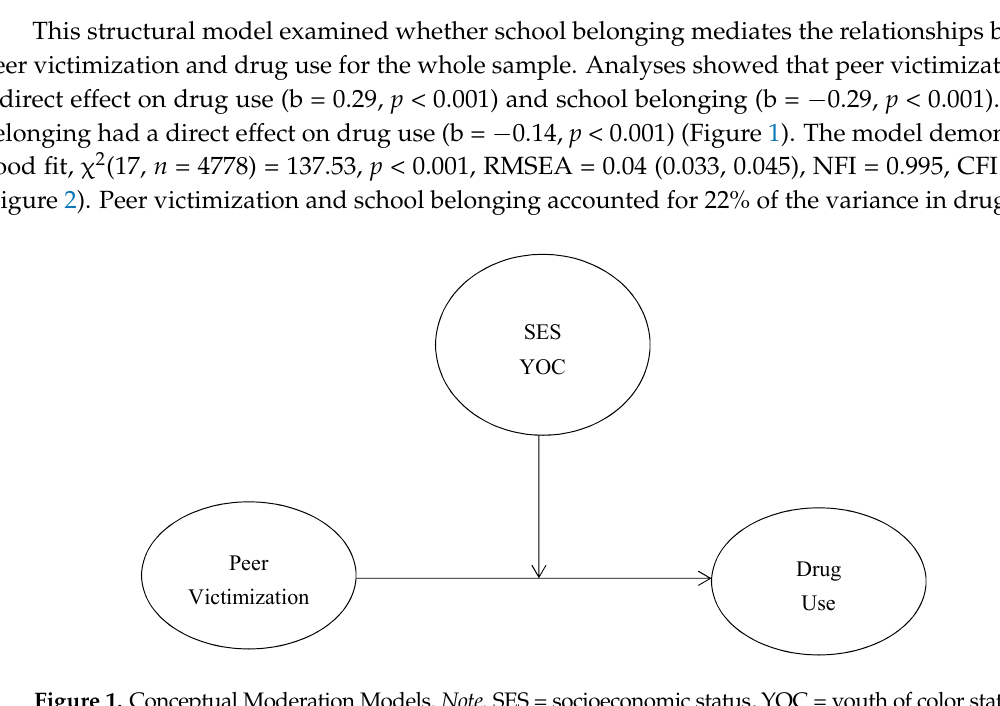
Figure 2. Structural equation model with latent variables and standardized estimates; * = p < 0.001. 6. Moderated Mediation 6.1. Structural Model 4 Invariance testing was utilized to examine whether group differences emerged in the mediation model. Model 5 compared transgender youth who were low SES versus those who were not. Fit indices showed that the groups did not vary in regression coefficients, but did vary in means (Table 2). These findings suggest that mean differences exist (see structural model 1), but that SES did not moderate indirect effects in the mediation model.